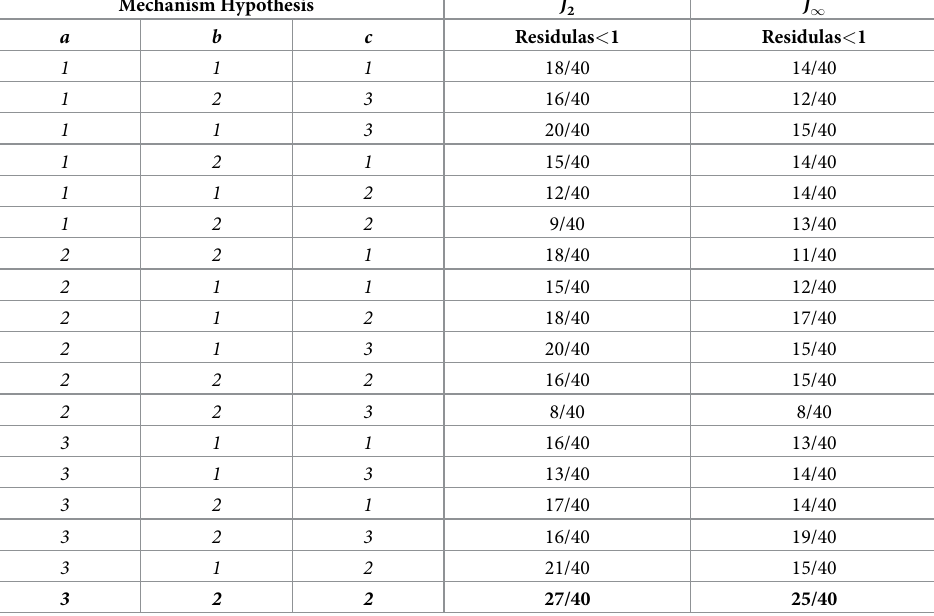
Table 3. Residuals lower than one for comprehensive ODE of all 18 combinations of hypotheses. Estimated parameters of the two best-fitting models. First column is the parameter notation used in the equations. Second col- umn is the biological meaning of the parameter. Third and fourth columns are the parameter values for both models. Fifth column is the parameter unit. Sixth column is the reference used for retrieving parameter value, when it was pos- sible/available. Parameters for which no reported estimation could be found were estimated by fitting on experimental data. Mechanism Hypothesis J